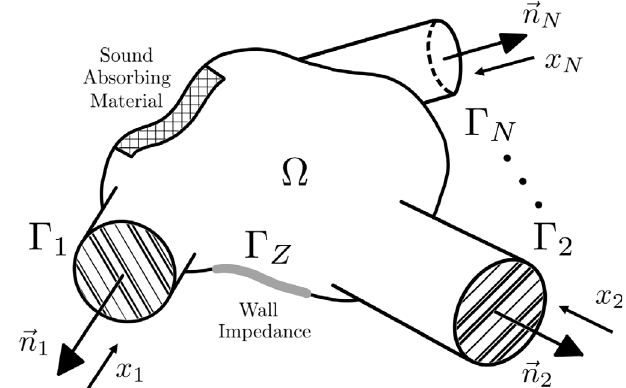
Figure 2. Acoustic system with N ports.